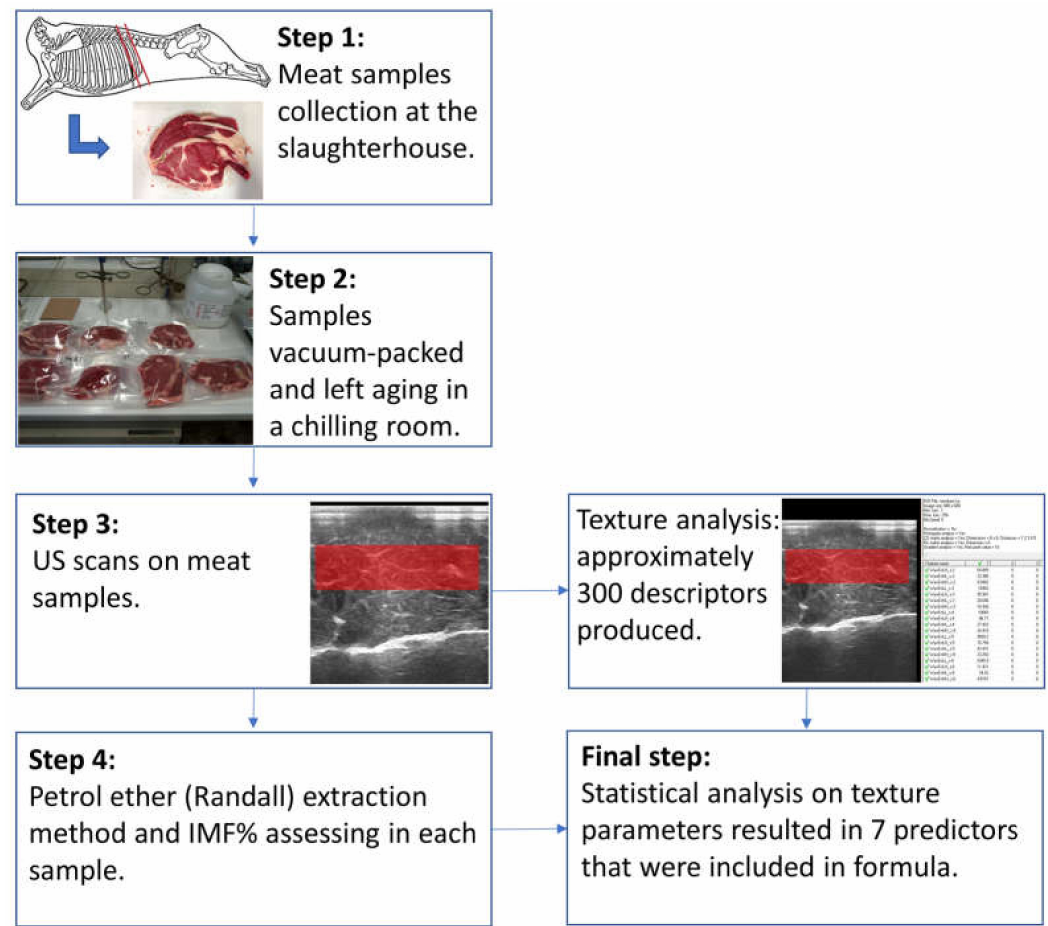
Figure 1. Operational flowchart of methods in the